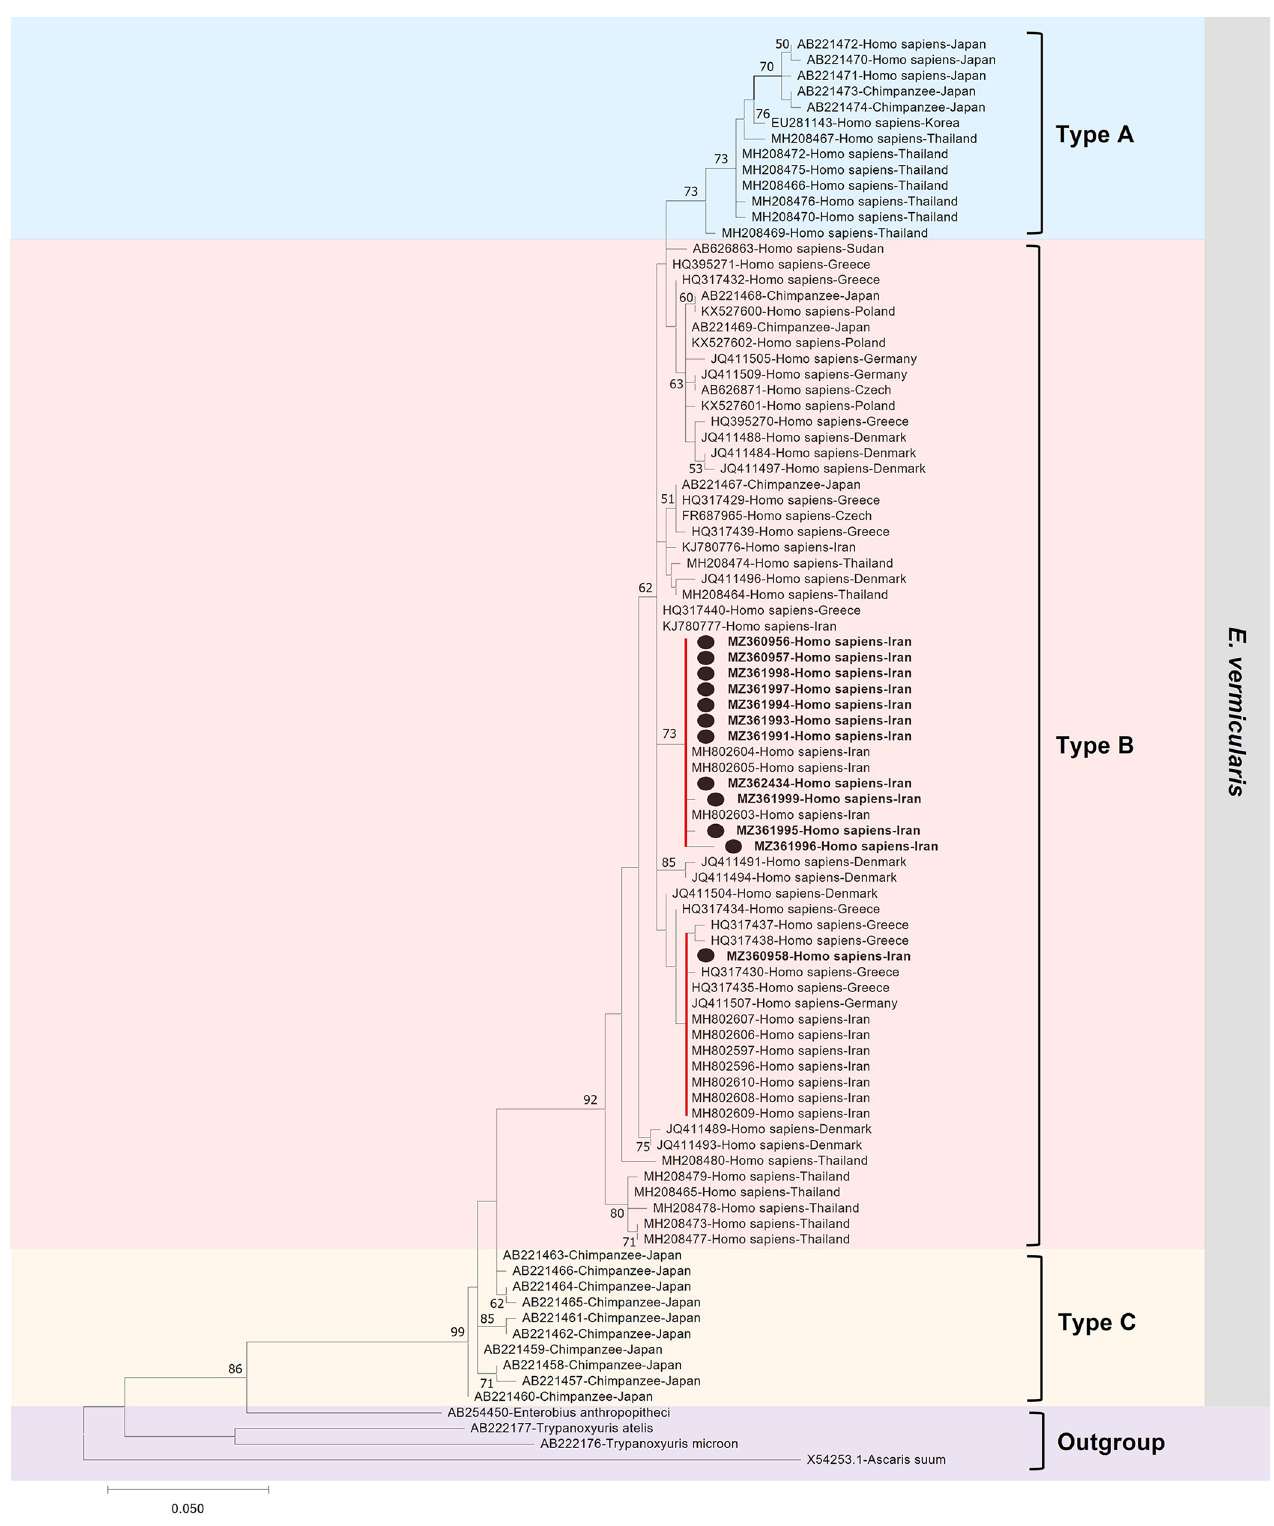
Fig 5. Phylogenetic relationships were inferred from 333 bp of c ox1 gene sequences of Enterobius vermicularis isolates in this study (black circles) and others retrieved from GenBank. The tree was constructed based on the maximum likelihood method in MEGAX with Ascaris suum as the outgroup.